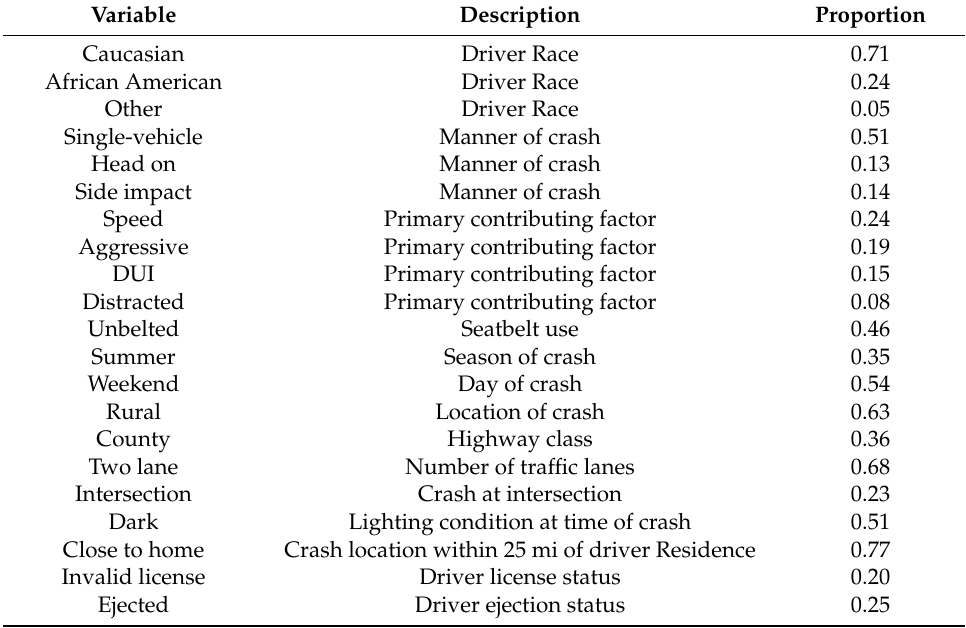
Table 1. Summary statistics of crash